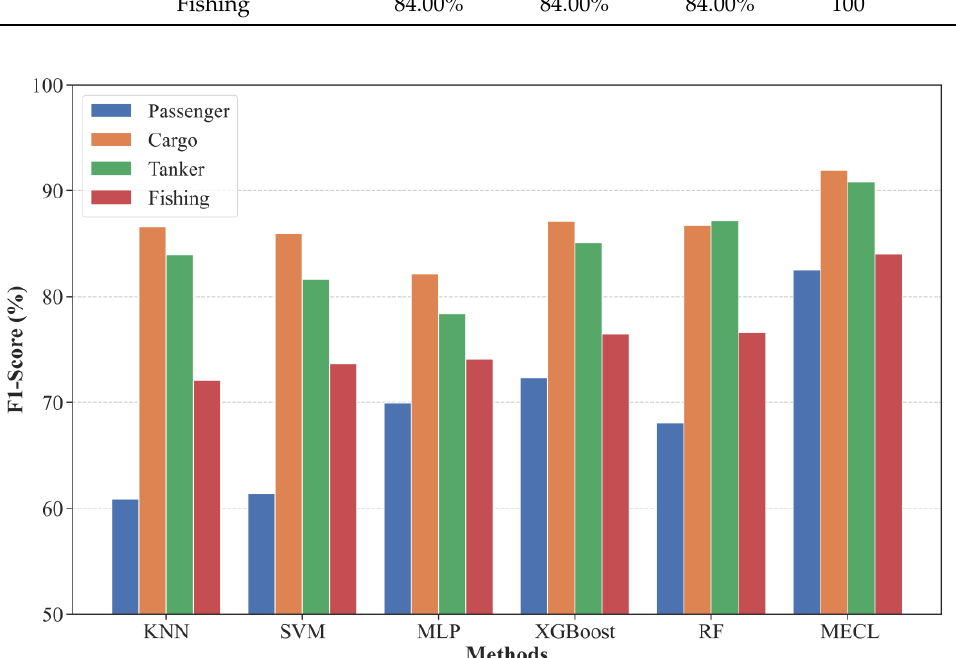
Figure 11. F 1 -Score of different classification methods for four types of